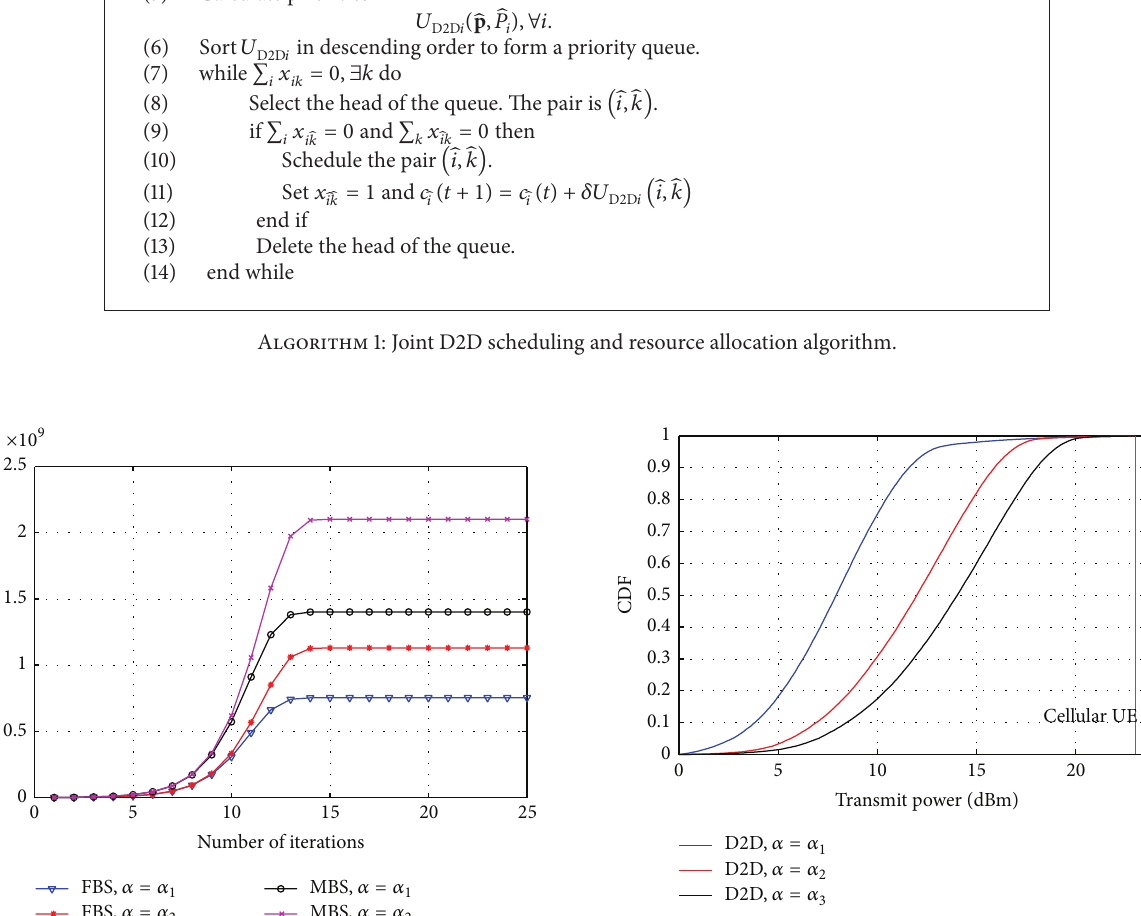
Figure 2: Prices of MBS and FBS uder different 𝛼 .